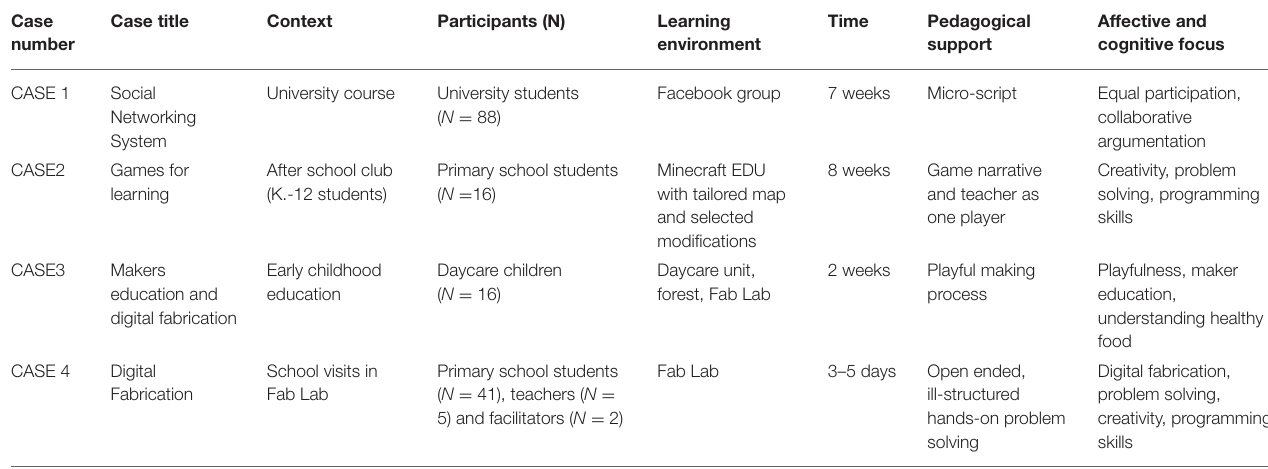
TABLE 1 | Summary of the case examples: social networking systems, games for learning, maker education, and digital fabrication. Case